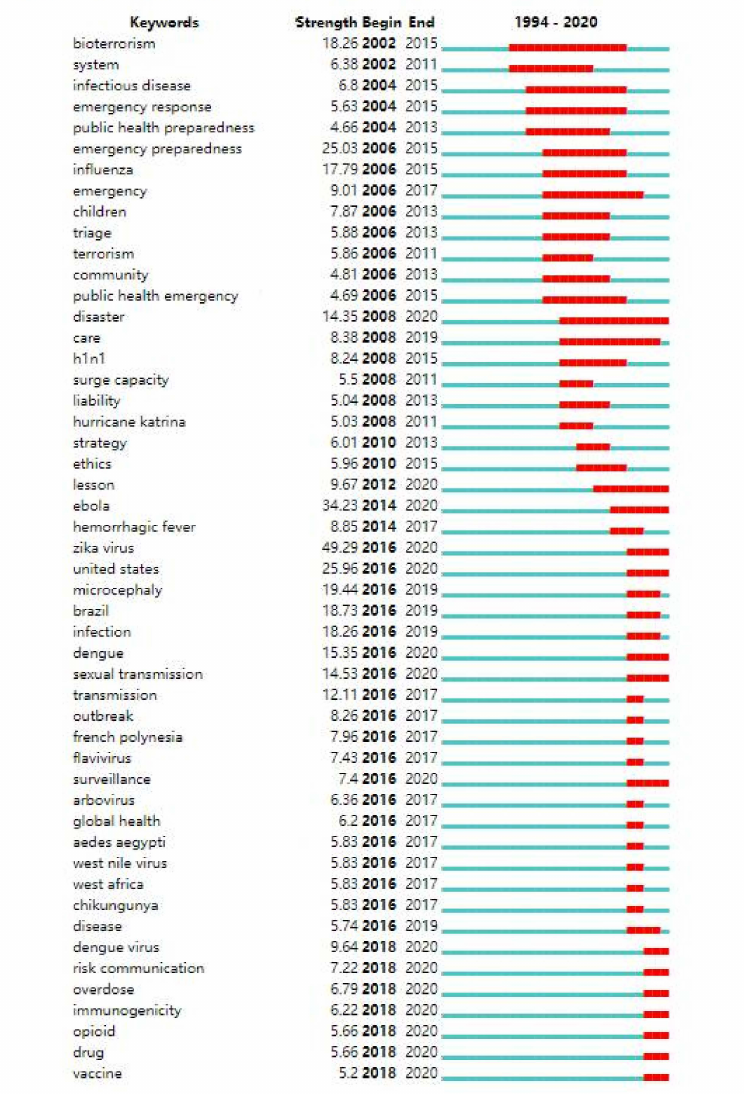
Figure 6. Top 50 keywords with strongest citation bursts (sorted by emergent